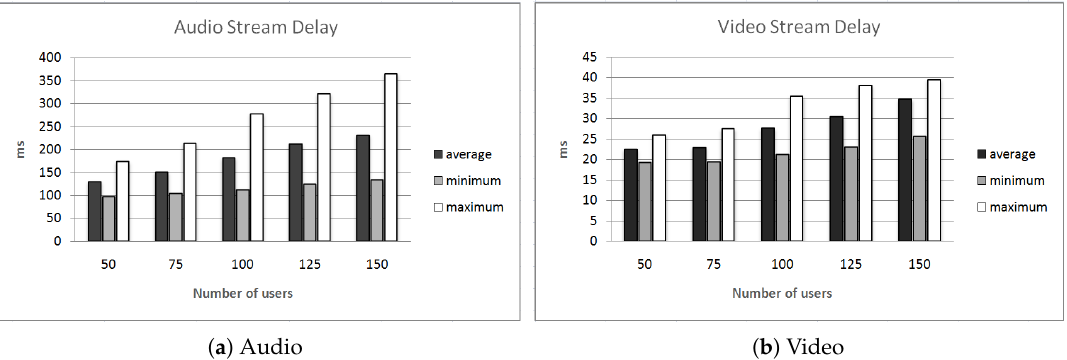
Figure 12. Audio and video stream delay (average, minimum, and maximum) varying user